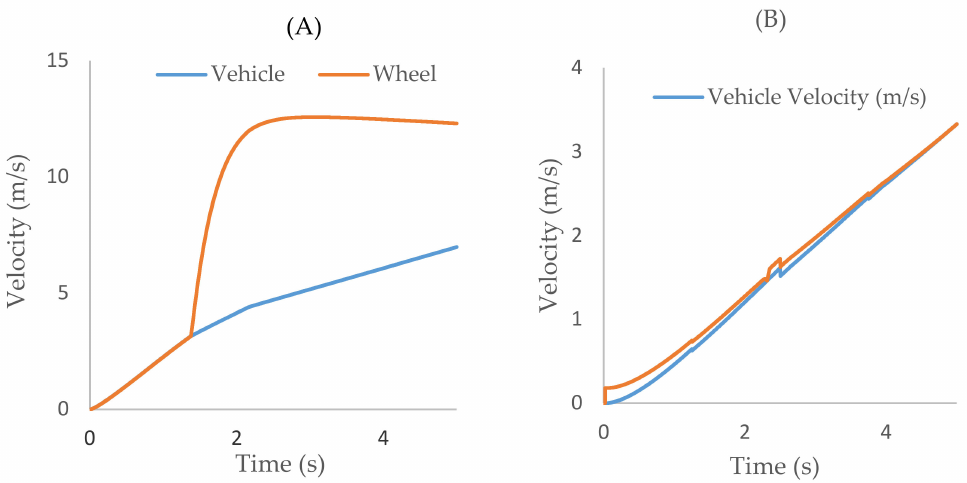
Figure 10. Velocity performances ( A ) without control and ( B ) with control.